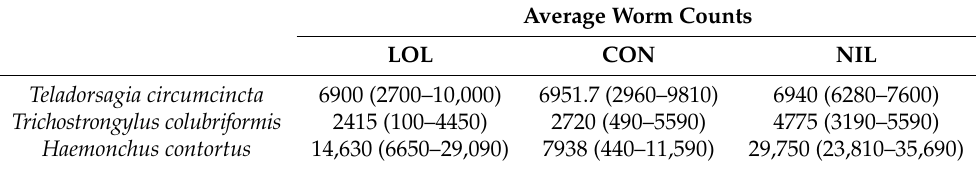
Table 5. Average worm counts of lambs treated with a meadow fescue seed extract with (LOL, n = 7) or without loline (NIL, n = 2), or non-treated (CON, n = 7) at L4 or adult worm stage of Teladorsagia circumcincta , and Trichostrongylus colubriformis , or adult Haemonchus contortus .